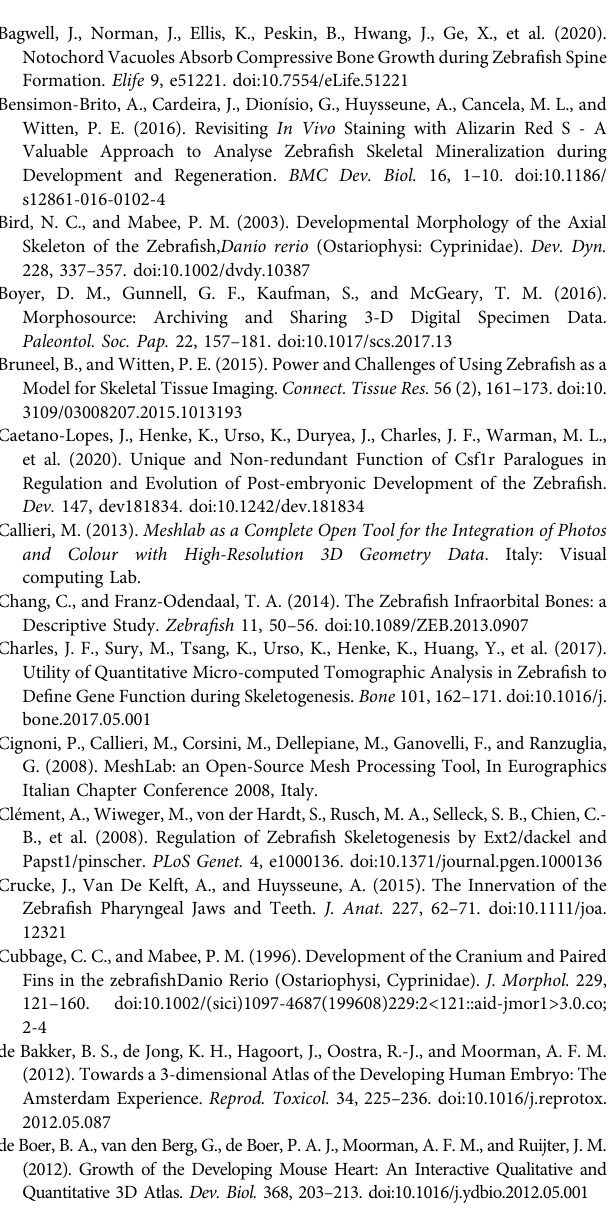
Supplementary Figure 3 | Histogram showing size distribution of samples scanned. Each dot represents a single individual; orange dots represent female fi sh and green dots represent male fi sh. Grey dots indicate fi sh that were too immature to be accurately sexed. Supplementary Figure 4 | (A) , Average density of individual slices along the anterio-posterior axis of individual zebra fi sh at four sizes. (B) , Normalized density plotted against the proportion of the body length. Supplementary Figure 5 | Interactive PDF of 3D model of 12 mm SL zebra fi sh whole head (top) and whole body (bottom) scans. Supplementary Figure 6 | Interactive PDF of 3D model of 16 mm SL zebra fi sh whole head (top) and whole body (bottom) scans.